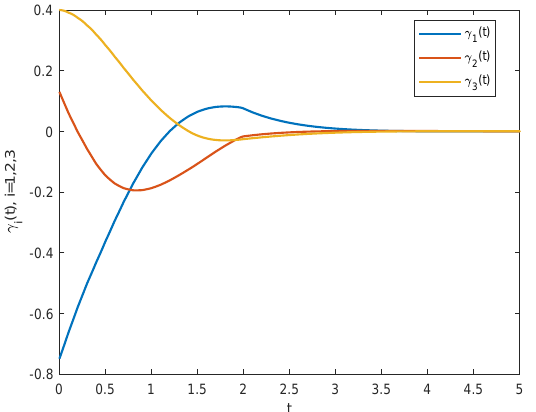
Figure 5. Schematic of the error system γ ( t ) under the saturated aperiodic SD controller of Example